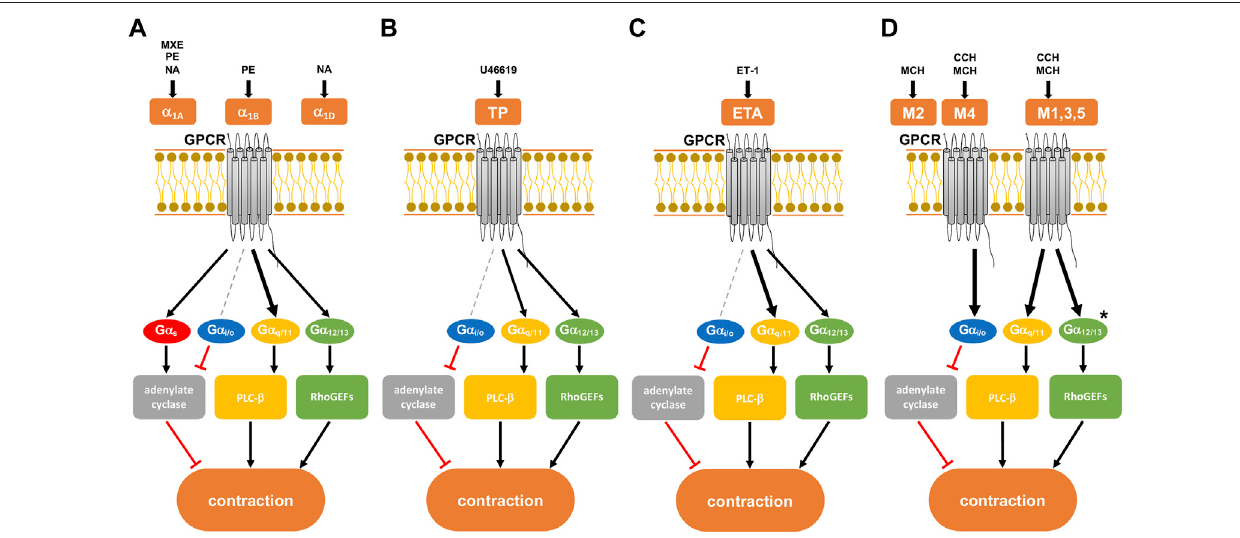
FIGURE 1 | Presumed intracellular signaling pathways of G-protein coupled receptors (GPCRs) in smooth muscle contraction. GPCR activation leads to shared, but possibly also to family- or subtype-speci fi c responses in intracellular signaling, the latter being imparted by different patterns of G protein coupling. G α q/11 proteins maypreferentiallyactivatephospholipase(PLC)- β ,leadingtotheproductionofinositol-1,4,5-trisphosphate(IP3)anddiacylglycerol(DAG).G α 12/13proteinsinteractwith RhoGEFs and consequently preferentially active RhoA/Rho kinase. The G α s protein family activates adenylate cyclase, while the G α i/o protein family inhibits the enzyme. (A) α 1 -adrenoceptor with its subtypes ( α 1A,B,D ), activated by methoxamine (MXE), phenylephrine (PE), and noradrenaline (NA). All three subtypes are present in the hyperplastic prostate at a ratio of 85:1:14 for α 1A : α 1B : α 1D . (B) Thromboxane receptor (TP), activated by the thromboxane A2 analog U46619. (C) Endothelin A receptor (ETA), activated by endothelin-1 (ET-1). (D) Muscarinic receptor with its subtypes M1-5. All subtypes of muscarinic receptors are activated by methacholine (MCH), while carbachol (CCH) only activates subtypes M1, M3-5. Human detrusor smooth muscle predominantly contains subtypes M2 and M3 at a ratio of 3:1. After Alexander et al. (2021). Previously supposed, receptor-speci fi c preferences in G protein coupling and intracellular receptors are indicated by different arrow sizes (bold, presumably predominant pathway for a receptor) (see text for details). * presumed signaling pathway of M3 receptors in the human